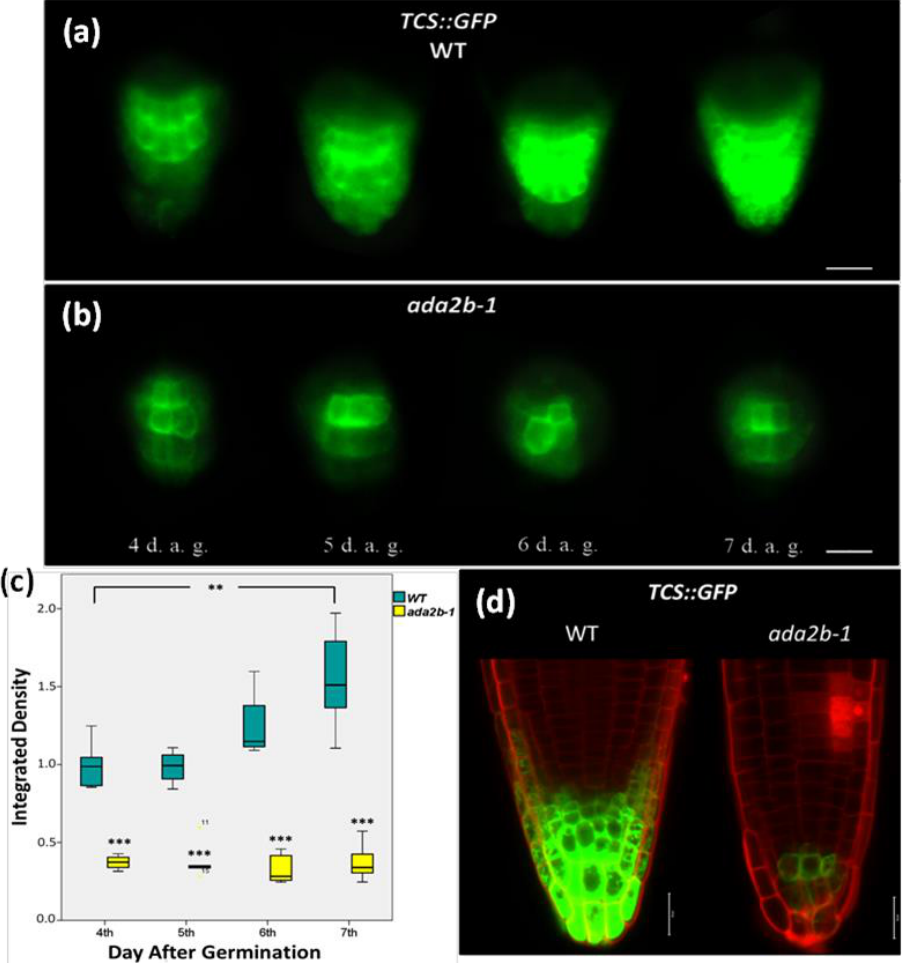
Figure 1. ADA2b affects cytokinin signaling at the first stages of root growth in Arabidopsis thaliana . The expression of reporter gene TCS :: GFP in roots of ( a ) wild type (WT) and ( b ) ada2b-1 mutant plants 4, 5, 6, and 7 days after germination (d.a.g.). Scale bars represent 50 µ m. ( c ) The graph indicates the fluctuation of fluorescence density between WT and ada2b-1 during root growth. The bars represent the range of the two quadrants, the horizontal line in the bar the median, while the terminals the minimum and maximum value of the data. Asterisks above bars of ada2b-1 indicate statistical significance compared to the same d.a.g. of WT, while asterisks between brackets indicate the difference between 4th and 7th d.a.g., using an independent samples t -test: * p < 0.05, ** p < 0.01, and *** p < 0.001. ( d ) TCS :: GFP expression in 7-day-old roots of WT and ada2b-1 stained with iodide propidium is detected using confocal fluorescence microscopy. Scale bars represent 20 µ